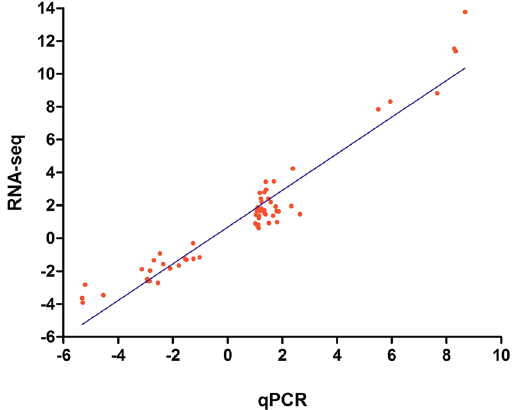
Figure 7. Coefficient analysis between gene expression fold changes obtained from RNA-seq and qRT-PCR data of 30 genes. The RNA-seq log2 values (fold changes; y-axis) were plotted against log2 value of qRT-PCR